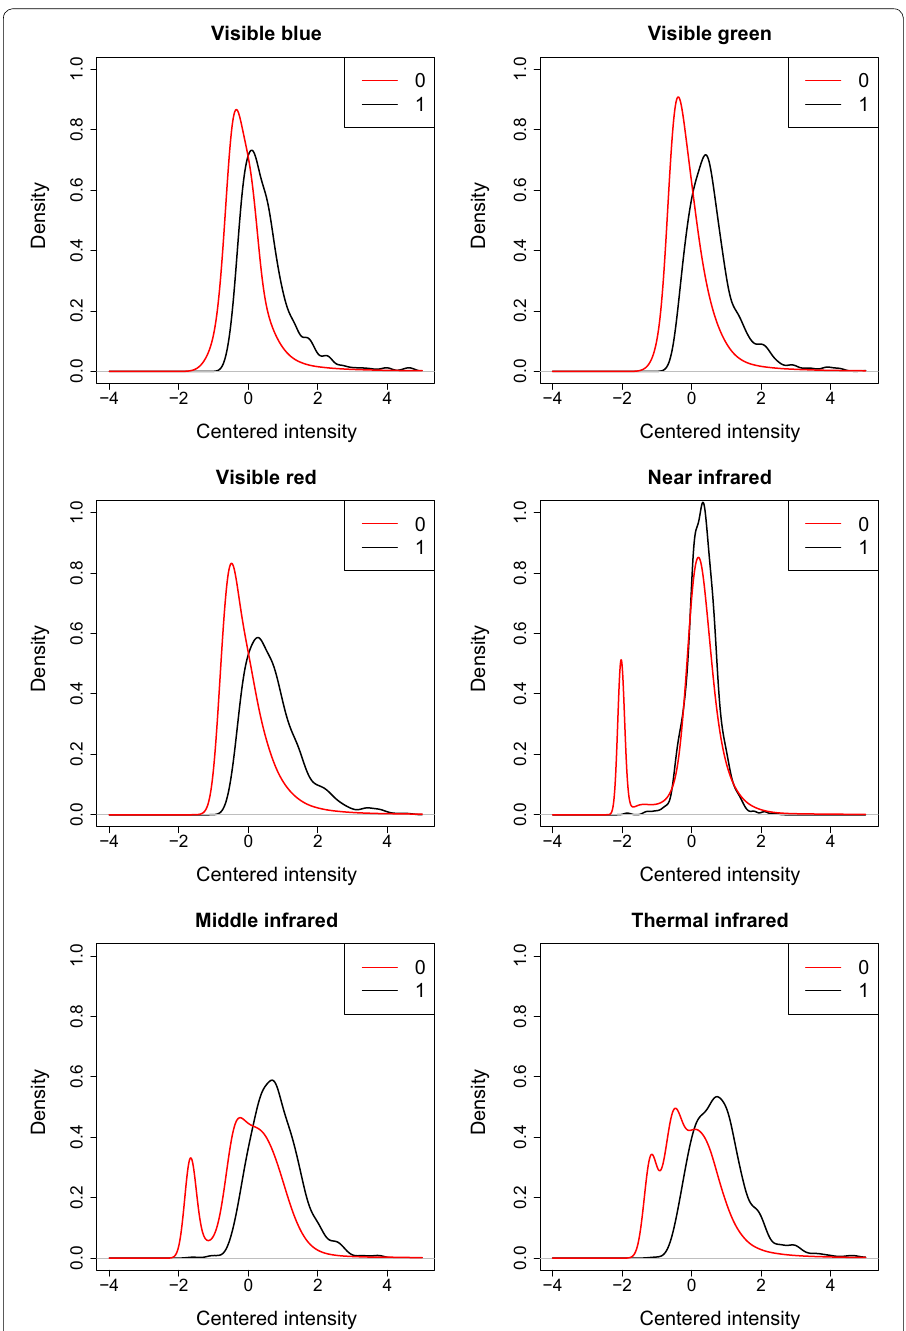
Fig. 5 Densities of 6 Landsat bands from 2005 image with 1 (in black) indicates colonies are identified and 0 (in red) indicates